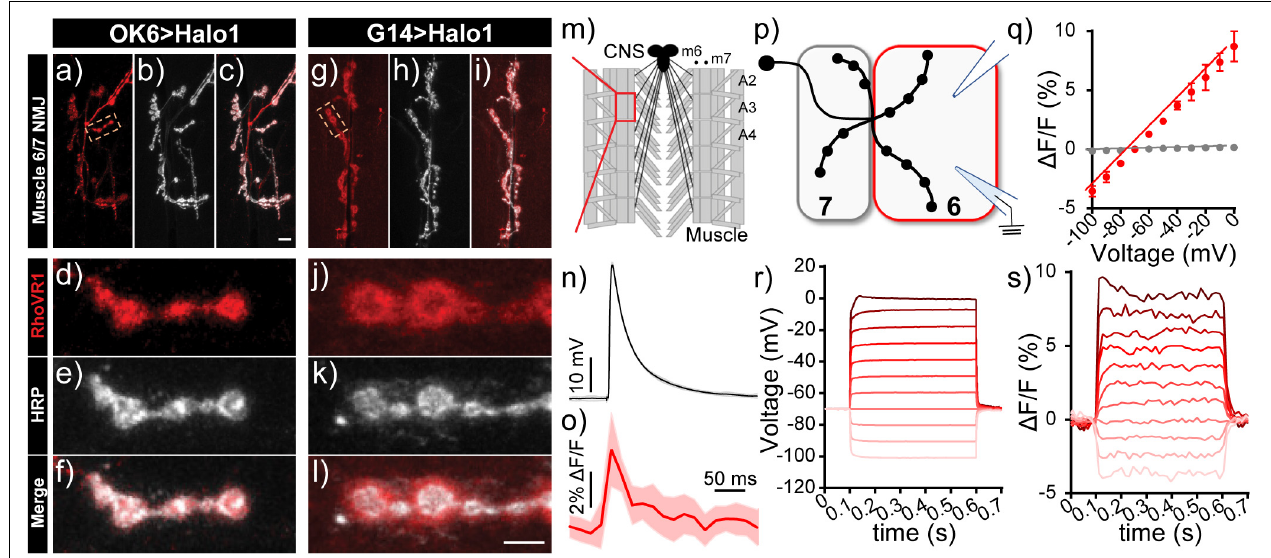
FIGURE 7 | Voltage imaging with RhoVR-Halo using the Drosophila neuromuscular junction (NMJ). (a–l) Confocal images of motor neurons labeled with RhoVR-Halo (2 µ M) in NMJs of (a–f) presynaptic neuron-labeled OK6-GAL4 > Halo-CD4 flies or (g–l) post-synaptic muscle-labeled G14-GAL4 > Halo-CD4 flies. Red is RhoVR-Halo fluorescence; gray is HRP—a neuronal membrane marker. Scale bars are 10 µ m (a–c,g–i) and 5 µ m (d–f,j–l) . (M) Schematic of Drosophila NMJ. Excitatory post-synaptic potentials (EPSPs) recorded at NMJs of G14-GAL4 > Halo-CD4 larvae stained with RhoVR-Halo (2 µ M). Sharp electrode recordings of EPSPs are in (n) gray, and (o) optically recorded EPSPs are in red. Data are mean ± SEM of eight replicates. (p) Schematic of two-electrode measurements. Muscle cell 7 is unclamped, while the membrane potential of muscle cell 6 (m6) is clamped, held at –70 mV, and stepped to hyper- and depolarizing potentials ranging from –100 mV to 0 mV. (q) Plot of (cid:49) F/F vs. holding potential for m6 (clamped, red) or m7 (unclamped, gray) in G14-GAL4 > Halo-CD4 flies stained with RhoVR-Halo. Data are mean ± standard error of the mean for n = 8 independent determinations. Example plots of change in (r) voltage or (s) fluorescence ( (cid:49) F/F) vs. time for the clamped m6